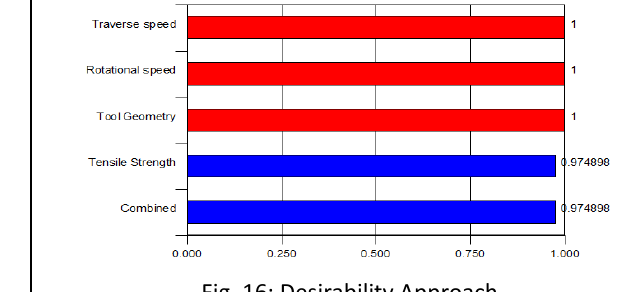
Fig. 16: Desirability Approach